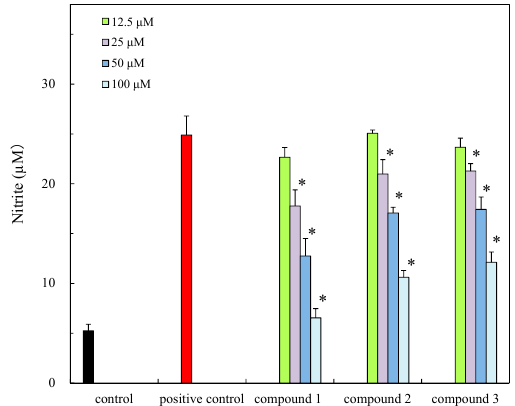
Figure 6. Anti ‐ inflammatory effect of 1 – 3 against NO production in LPS ‐ stimulated RAW264.7 macrophage cells. Significance * p < 0.01 was considered statistically significant for positive control.